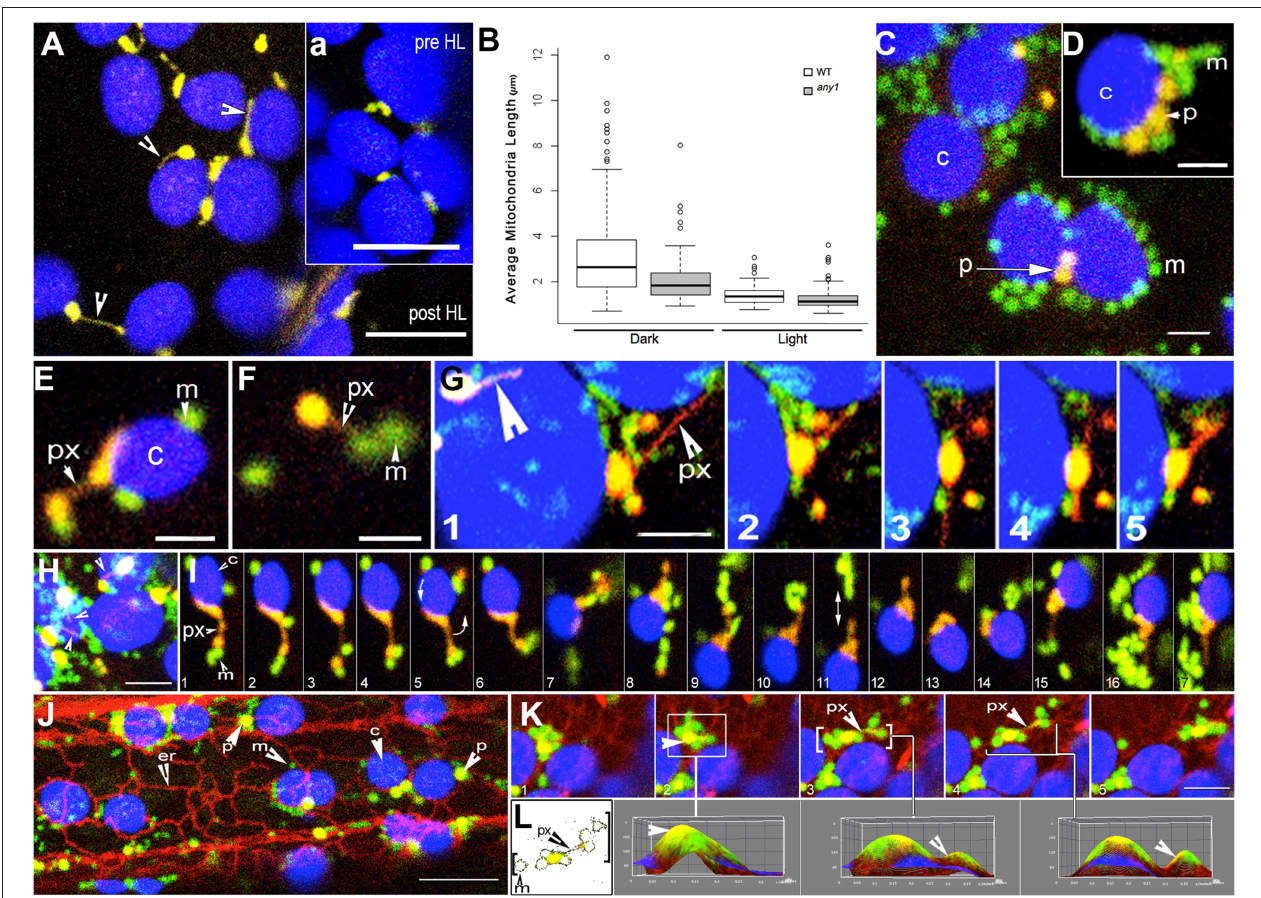
FIGURE 3 | Peroxisome and mitochondria in wild type and any1 mutant Arabidopsis plants. (A) A single cotyledon mesophyll cell exhibits peroxules in the YFP-PTS1 line in the any1 mutant. Time lapse sequence shown as Movie S4 . The inset “ a ” shows a portion of the same cell before HL exposure. (B) Mitochondrial length, taken as an indicator of increased cellular ROS is significantly smaller in the any1 mutant in comparison to WT under both light and dark growth conditions on medium without sugar ( p < 0.05 ). (C) Mitochondria and peroxisomes often cluster around chloroplasts in cotyledon and hypocotyl cells of WT seedlings following HL exposure ( Movie S1 vs. Movie S2 ). (D) Similar clusters to “ c ” are observed in swollen cells of any1 even under 125 ± 10 µ mol m 2 s 1 light intensity. Peroxisome numbers are often lower than mitochondria in these clusters. (E) A peroxule (px) extended by a chloroplast-associated peroxisome shows mitochondrial (m) association. (F) An independent peroxisome with extended peroxule associates with two mitochondria following a 4-min exposure to HL. (G) Dynamic extension (frames 1–3), retraction (frame 4) and change of direction of extension (frame 4,5) of a peroxule (px) from a chloroplast associated peroxisome. Multidirectional peroxule extension while the parent peroxisome remains in one location allows interactions with several mitochondria on different sides. A second peroxisome with an extended peroxule is indicated (large arrowhead). (H) Single cotyledon cell in the any1 mutant stably expressing YFP-PTS1 and mitoGFP shows several chloroplast-associated yellow-orange peroxisomes and peroxules (arrowheads) with clusters of mitochondria (green) ( Movie S5 ). (I) A series of 17 sequential time-lapse snapshots of a hypocotyl cell of the double transgenic any1 mutant show a chloroplast-associated peroxisome (orange-yellow) extending a peroxule. Note that the peroxisome-chloroplast association remains strong despite the rotation of the chloroplast (arrow in panel 5) while the mitochondrial population (green) that comes in contact with the extended peroxule is maintained even though individual mitochondria may join and leave the cluster ( Movie S6 ). (J) Hypocotyl cell in a triple transgenic Arabidopsis plant shows the typical associations formed between chloroplasts (c-blue) mitochondria (m-green) peroxisomes (p-yellow) and the ER (er-red) following a 4-min HL exposure ( Movie S7 ). (K,L) Analysis of sequential snapshots of a mitochondria-peroxisome cluster (yellow-green) moving past chloroplasts (blue) on an ER defined path. 3D surface plots corresponding to panels K2, K3, K4 show clear yellow peaks indicating the presence of peroxisomes within the cluster whereas color thresh-holding and skeletonizing in “L” reveals the presence of a thin peroxule amongst mitochondria in panels K3 and K4. Size bars = (A,a) = 5 µ m; (C,D) = 2.5 µ m (E–I,K) = 5 µ m; (J) = 10 µ